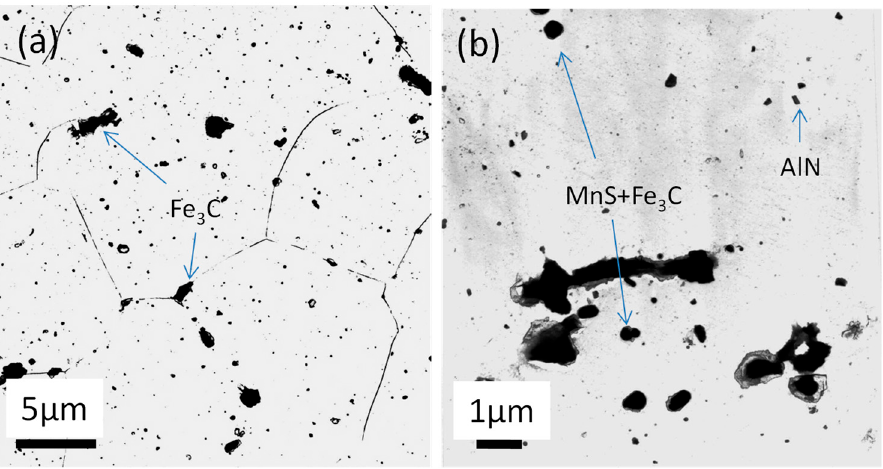
Figure 8. TEM carbon-replica micrographs from a CA low-carbon CQ strip sample showing ( a ) small carbides within grains and coarse carbides at grain boundaries; ( b ) co-precipitation of carbides with MnS and AlN.